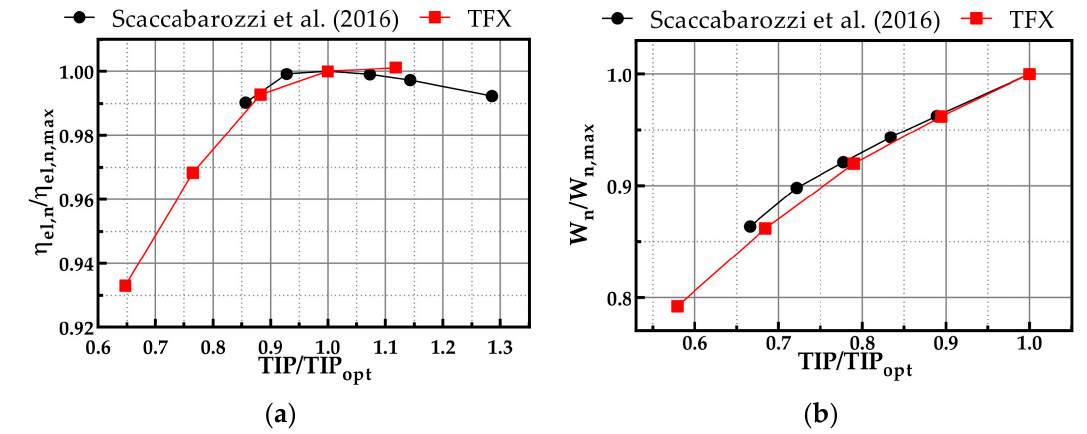
Figure 6. Allam cycle performance as a function of turbine inlet pressure: ( a ) net electric efficiency; ( b ) net specific work. Validation against Scaccabarozzi et al., thermodynamic analysis, and numerical optimization of the NET Power oxy-combustion cycle [26].